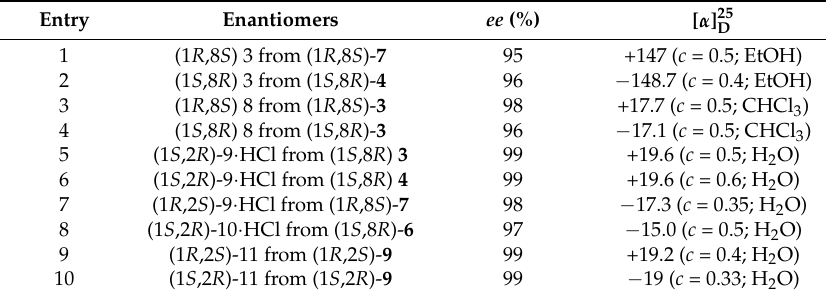
Table 4. Physical data on enantiomers